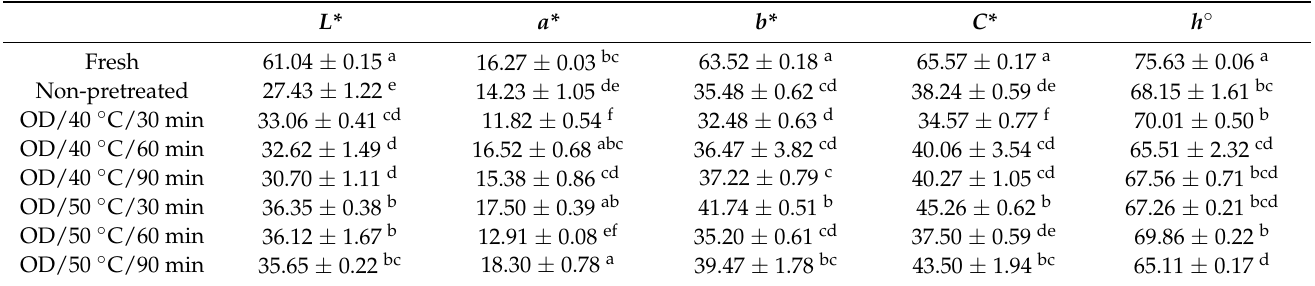
Table 2. Color values of fresh and pre-treated and vacuum dried kumquat